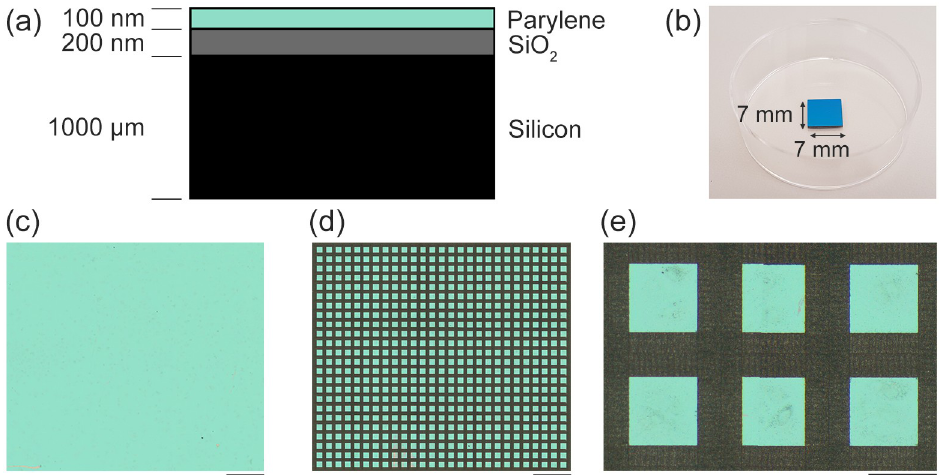
Fig 2. Description of parylene/SiO 2 substrates. (a) Vertical cross-section of a parylene/SiO 2 substrate (not to scale). (b) Image of a single blank parylene/SiO 2 sample. (c) An example of a parylene/SiO 2 substrate before and (d and e) after femtosecond IR laser micromachining. Green areas consist of parylene, whereas the grey areas consist of SiO 2 . Scale-bar = 1 mm in (c, d) and Scale-bar = 150 μ m in (e).